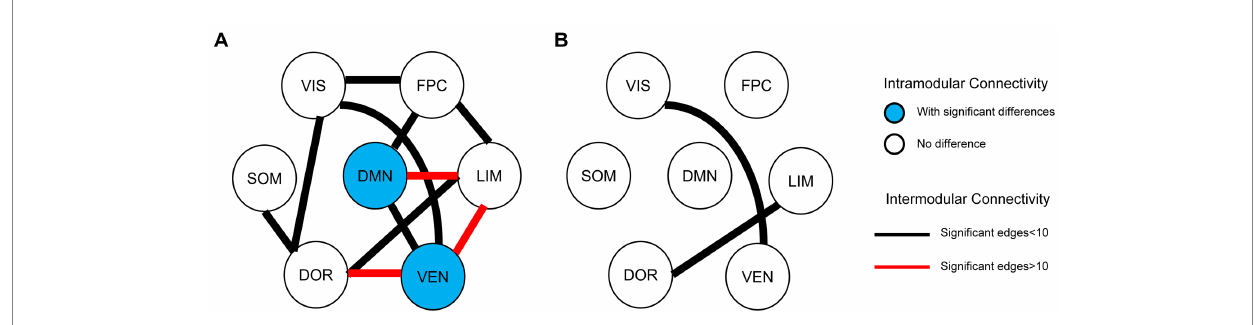
FIGURE 5 Intramodular and intermodular connectivity changes at follow-up. (A) Baseline vs. follow-up among EPRT- group; (B) EPRT+ vs. EPRT − at 1 year follow-up.